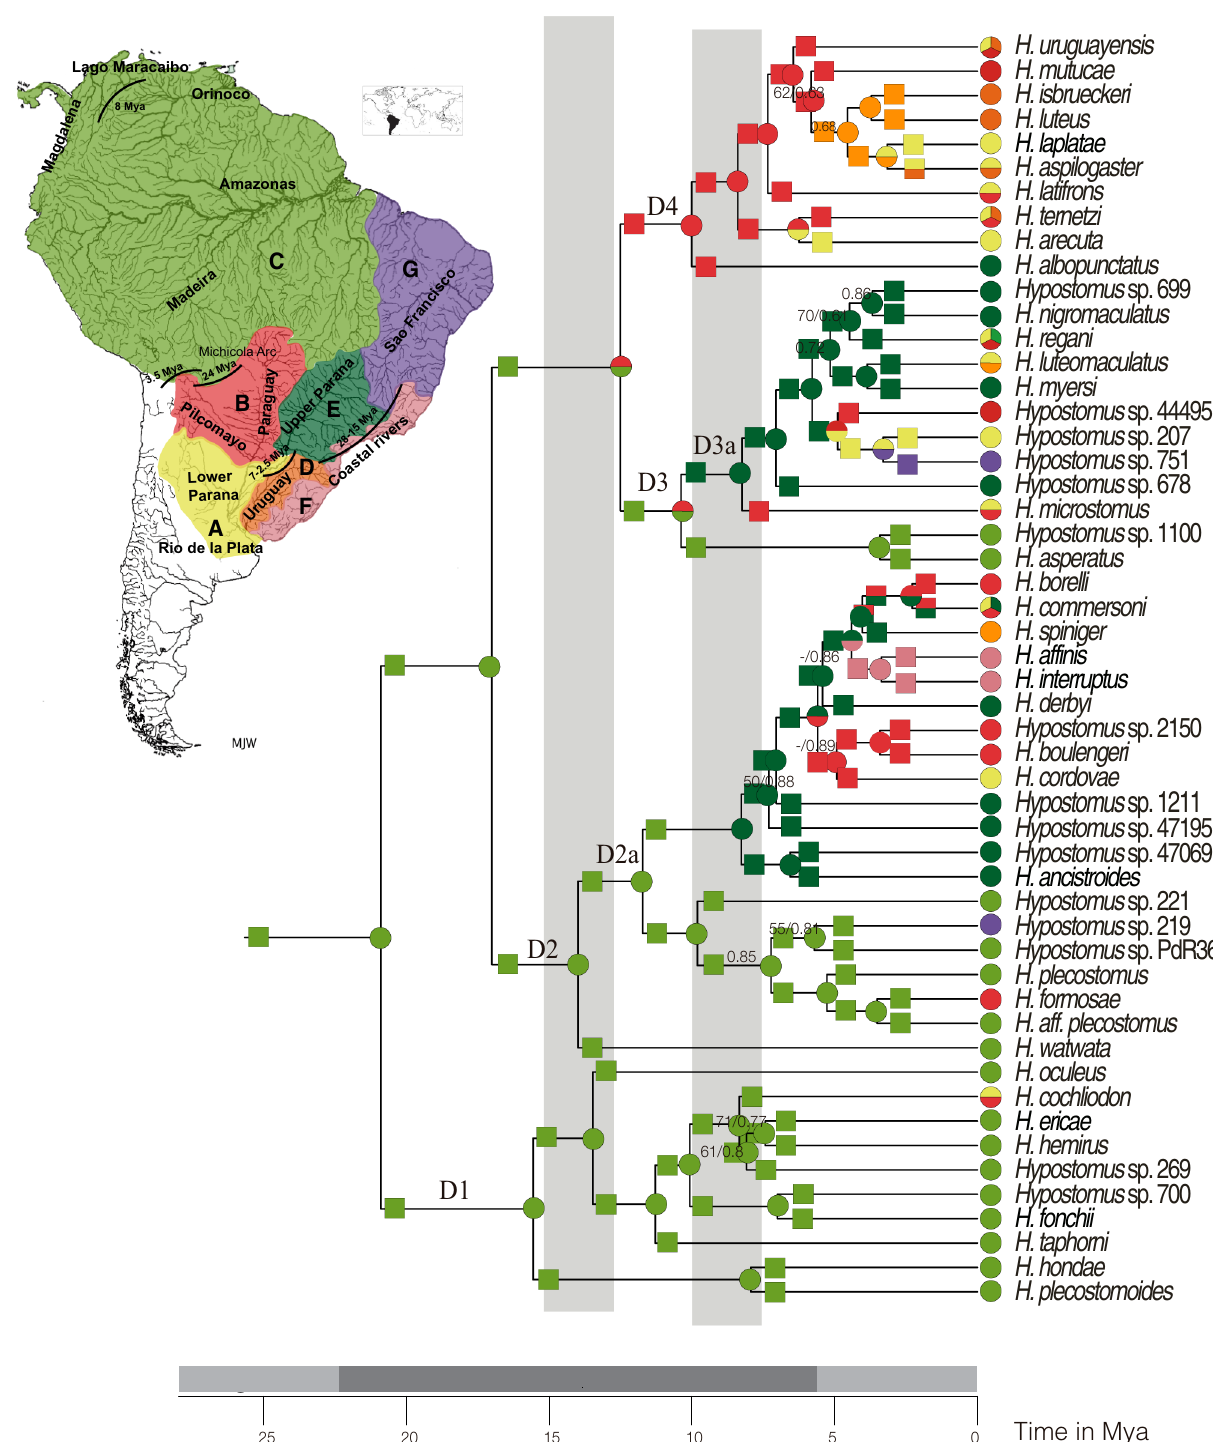
Figure 1. Time-calibrated multilocus phylogeny for the Hypostomus genus based on hydrogeological calibration points, including ancestral area reconstructions obtained using RevBayes. For the ecoregion codes and the D1–D4 clades, see text. Grey vertical bars are the maximum flooding events of the Miocene Marine ingression. Values in nodes show bootstrap supports lower than 80% and posterior probabilities supports lower than 0.9 performed in RaxML and MrBayes reconstructions, respectively. For the posterior probabilities of ancestral area reconstructions see Fig. S4. Map was created in CorelDRAW Graphics Suite 2020